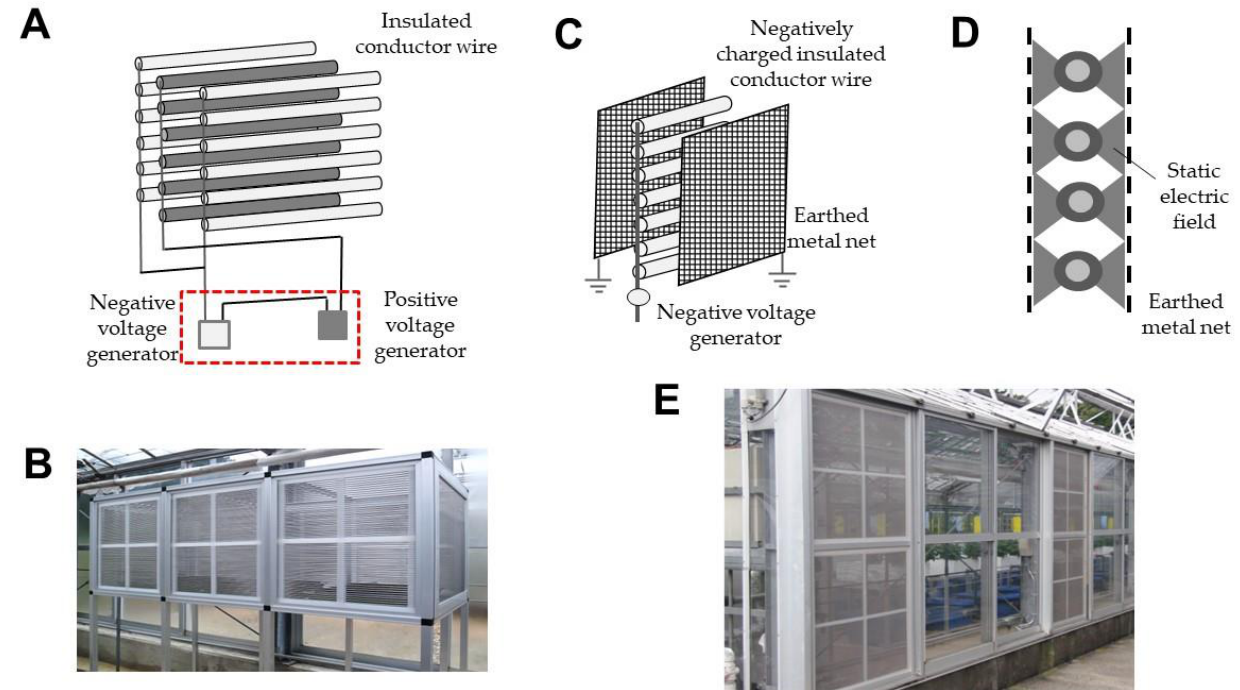
Figure 8. ( A , B ) Schematic representation of ( A ) a three-layer DD screen with a non-grounded circuit and ( B ) an electrostatic seedling shelter furnished with three-layer DD screens; ( C , D ) schematic representation of ( C ) a single-charged dipolar electric field screen, consisting of grounded metal nets on either side of a layer of negatively charged insulated conductor wires (ICWs); and ( D ) static electric fields formed between the negatively charged ICWs and grounded metal nets; and ( E ) installation of single-charged dipolar electric field screens in the lateral windows of a greenhouse.